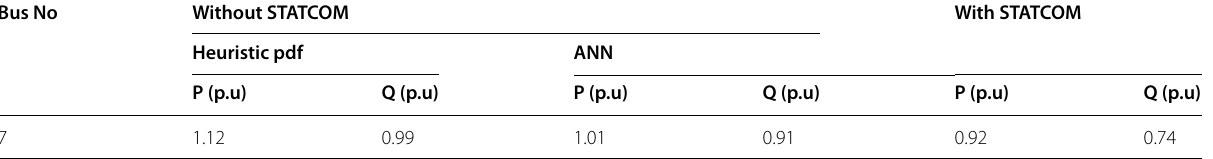
Table 25 Power flow comparison with and without presence of STATCOM at bus 7 of IEEE 9 -bus system Bus No